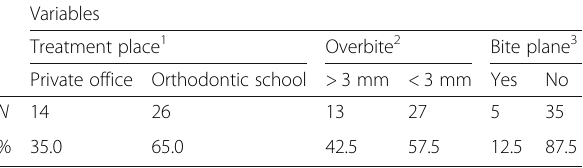
Table 2 Descriptive statistics of bracket debonding incidence by treatment place, overbite, and use of bite plane